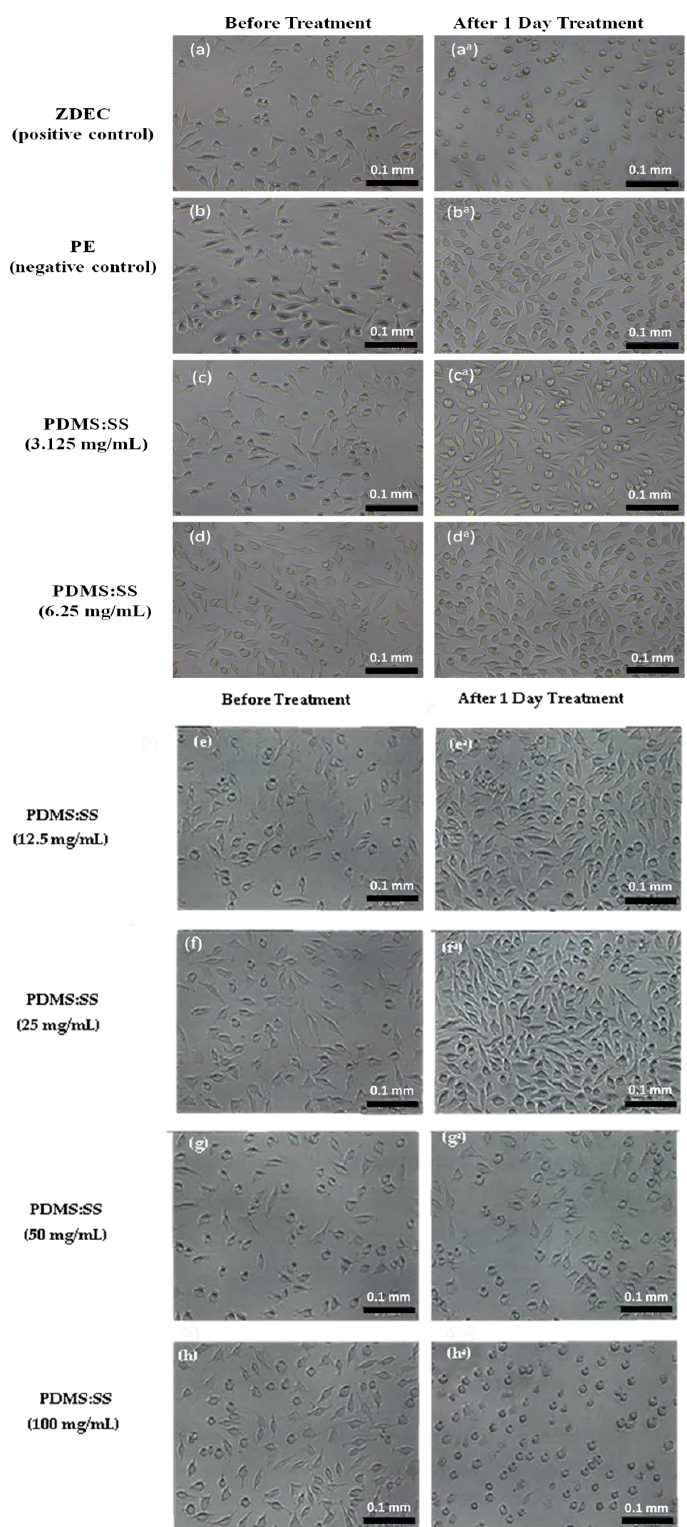
Figure 3. Cell morphology of L929 cells before being treated with ( a ) ZDEC, ( b ) PE, and PDMS: SS coating extract at; ( c ) 3.125 mg/mL; ( d ) 6.25 mg/mL; ( e ) 12.5 mg/mL; ( f ) 25 mg/mL; ( g ) 50 mg/mL; ( h ) 100 mg/mL. Images on the left side show the cell morphology of L929 (a, b, c, d, e, f, g, and h) before treated with the corresponding test items and Images on the right side (a a , b a , c a , d a , e a , f a , g a , and h a ) show after treated with the corresponding test items (Taken at 100× magnification with a scale bar of 0.1 mm).